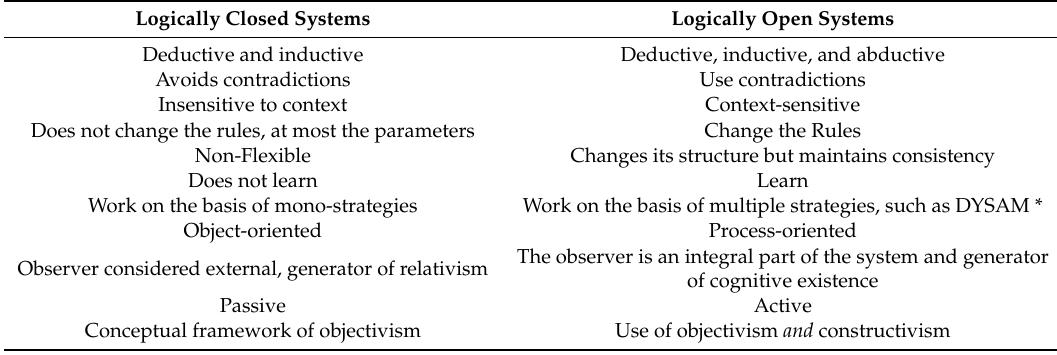
Table1. Aschematiccomparisonbetweenaspectsoflogicallyclosedsystemsandlogicallyopensystems. Logically Closed